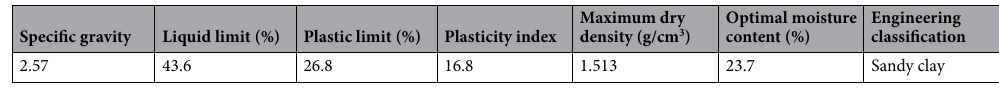
Table 1. Physical property indexes of the test